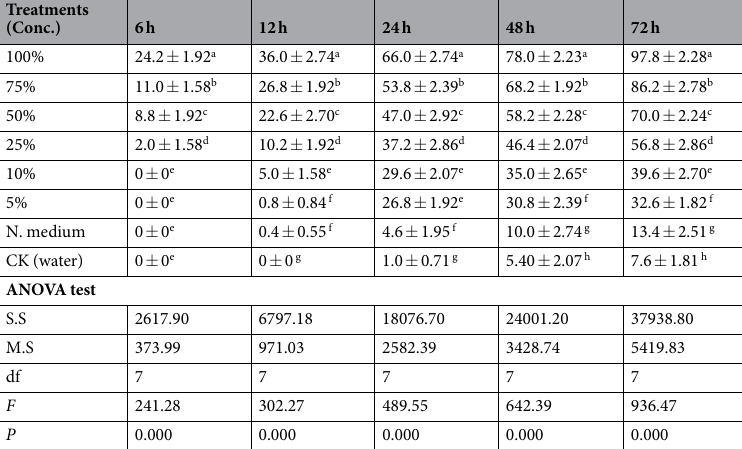
Table 3. Effect of Snef1216 against M. incognita juveniles. Data presents the mean ± standard deviation. The same letter within columns are significantly similar according to Duncan’s multiple range test ( P >